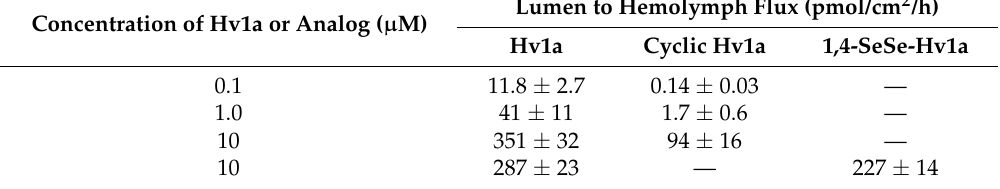
Table 3. In vitro lumen to hemolymph flux of Hv1a and analogs across the midgut of Manduca sexta larvae when present at different concentrations in the luminal fluid. Data are mean ± S.E.M, n = 9–19. Lumen to Hemolymph Flux (pmol/cm 2 /h) Concentration of Hv1a or Analog ( µ M) Hv1a Cyclic